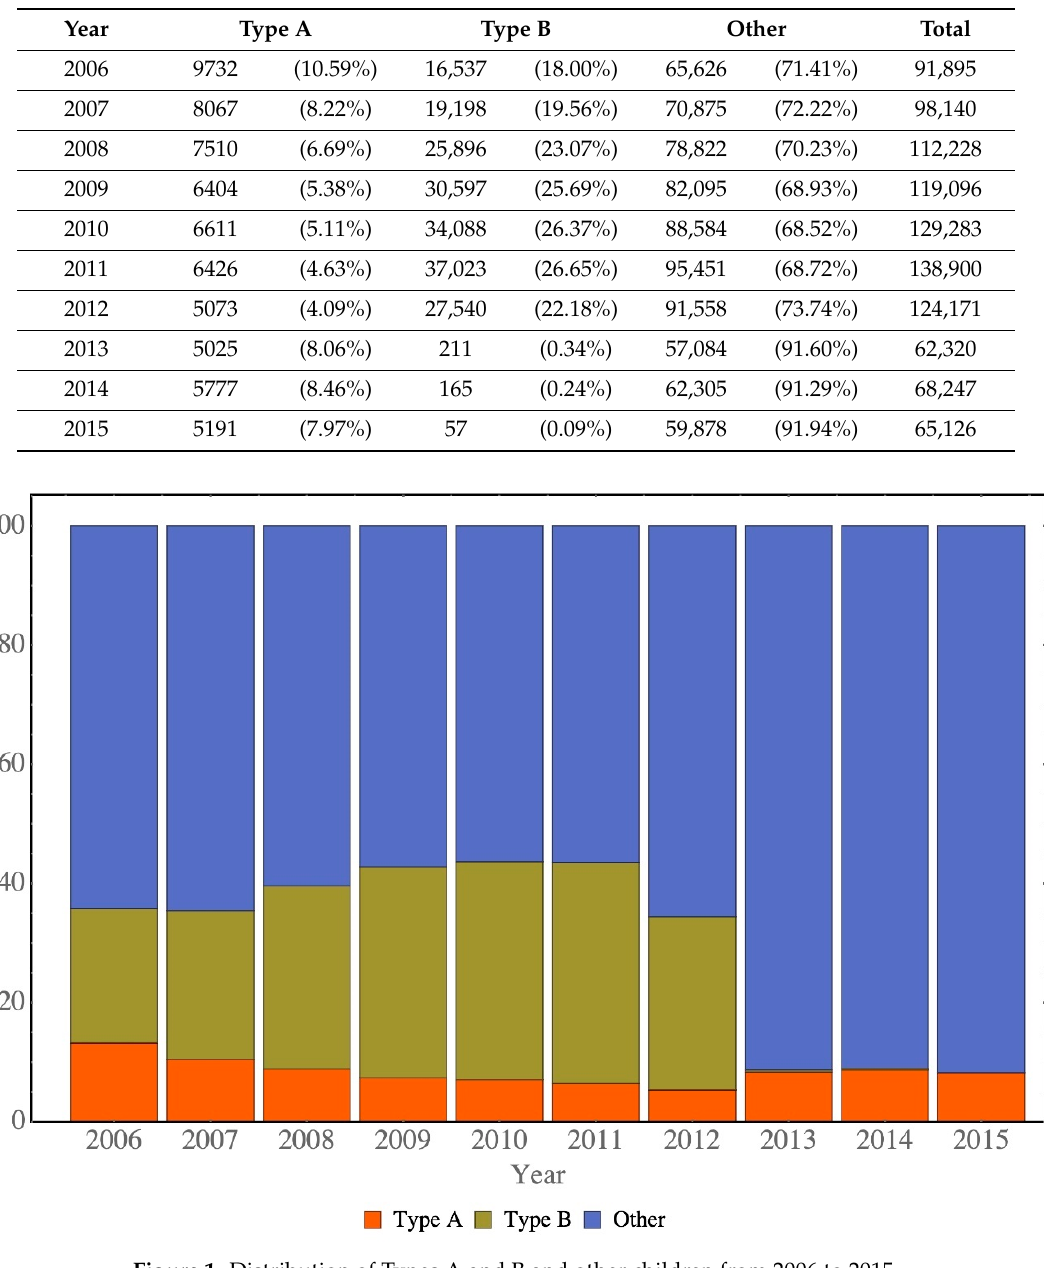
Figure 1. Distribution of Types A and B and other children from 2006 to 2015.